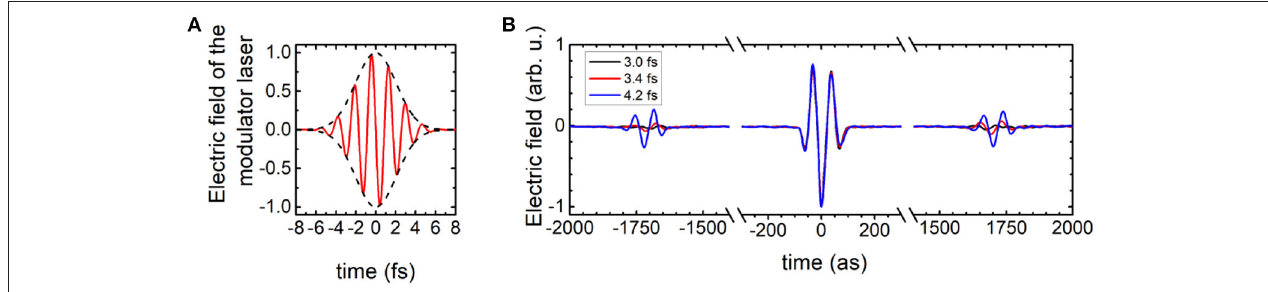
FIGURE 6 | (A) Electric field of a 2.0-cycle (3.40 fs) modulator laser pulse. (B) Time dependence of the electric field of the generated attosecond pulse train for different modulator laser pulse lengths.